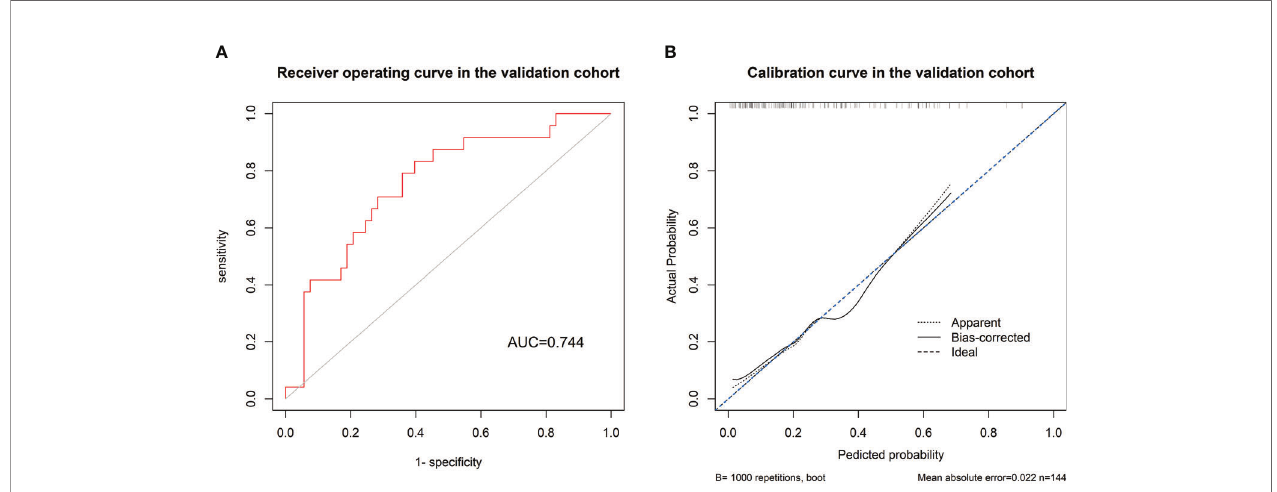
FIGURE 5 | (A) Receiver ’ s operating curve for validating the discriminative power of the model using data in the validation cohort, showing a satisfactory discriminative power of the model with an area under the curve of 0.744. (B) The calibration curve shows a good fi t between the data of the validation cohort and the model with a C-index of